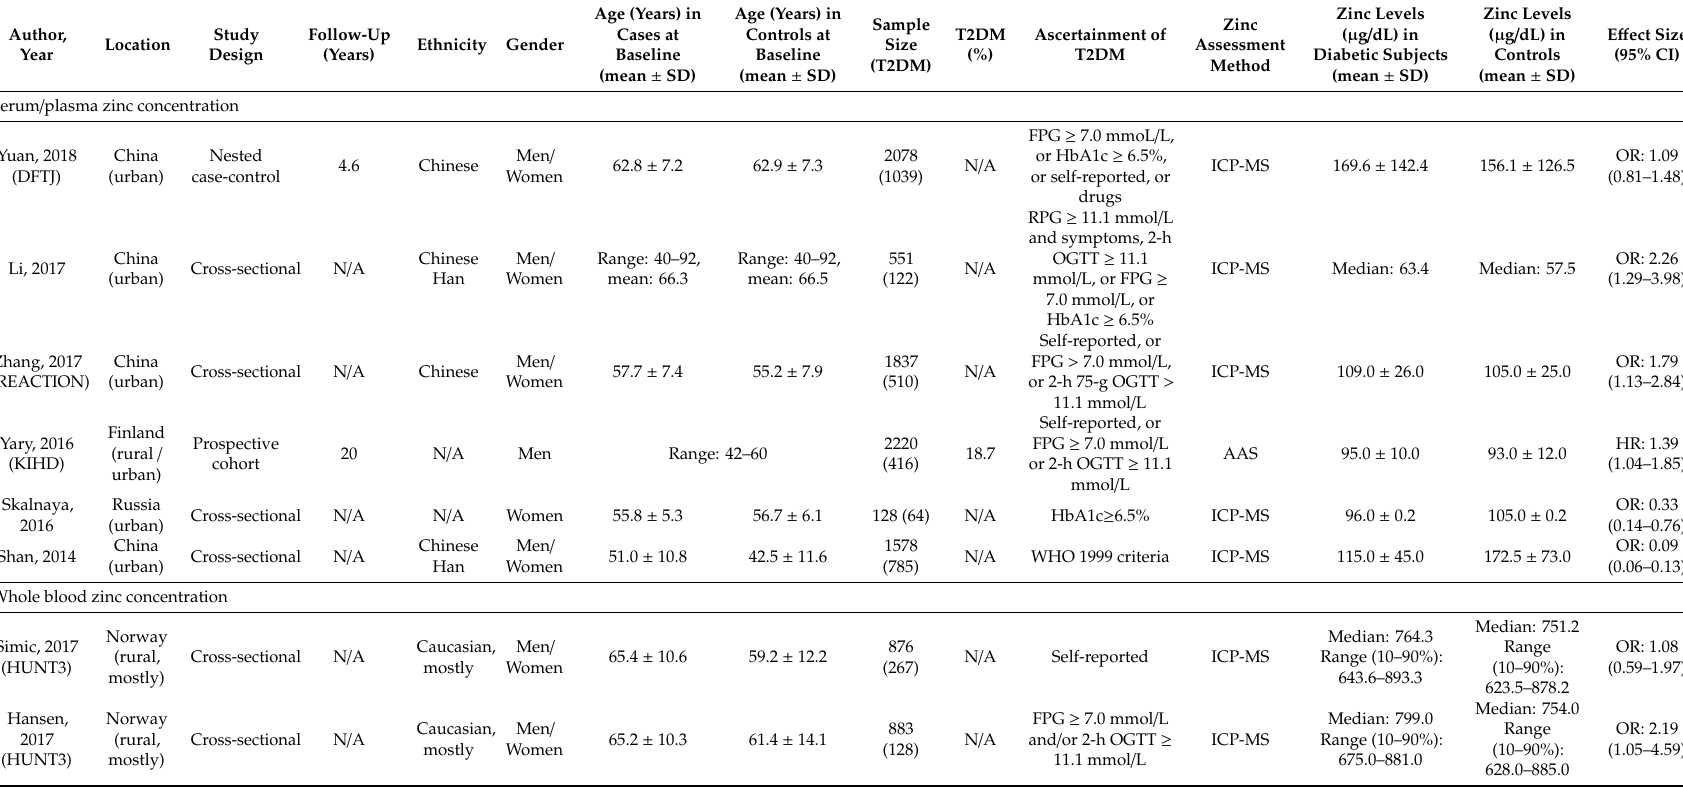
Table 3. Characteristics of studies reporting the association between serum / plasma and whole blood zinc concentration and risk of type 2